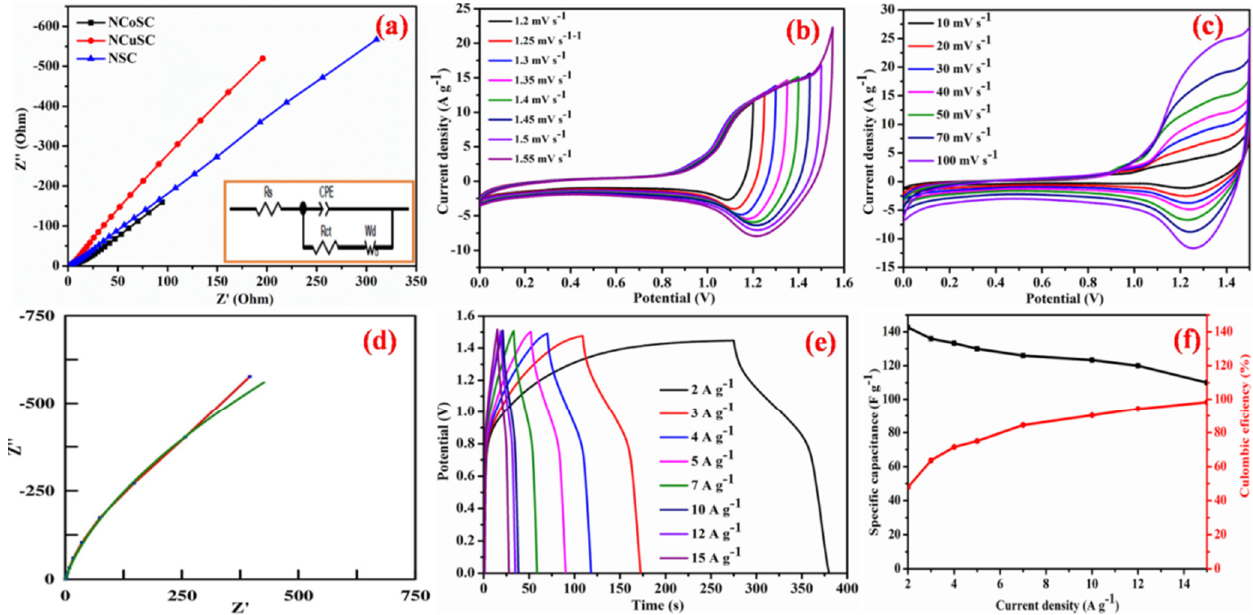
Figure 4. ( a ) EIS spectra of NSC, NCuSC, and NCoSC electrodes and Randle circuit (inset); ( b ) CV curves of HSC device at different working potential window; ( c ) CV curves HSC device; ( d ) fitted EIS spectra HSC device; ( e ) GCD plot at different current density HSC device; and ( f ) specific capacitance and columbic efficiency vs. current density plot of fabricated HSC device.